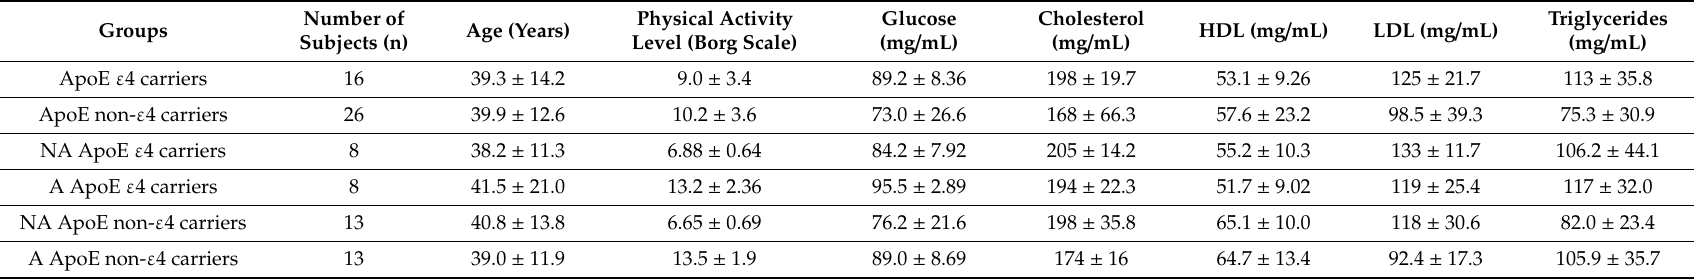
Table 1. Analysis of the total cohort of healthy